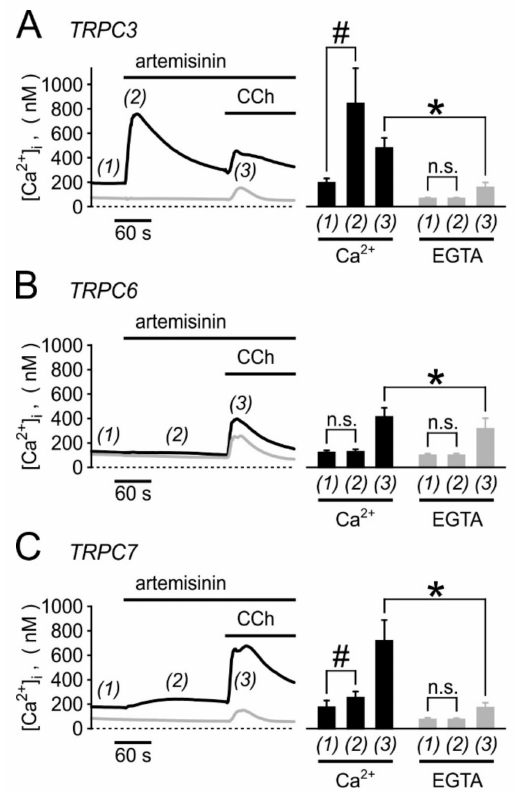
Figure 2. Microfluorometric single-cell analysis of artemisinin-induced increases in [Ca 2 + ] i in fura-2-loaded HEK cells stably expressing TRPC3 ( A ), TRPC6 ( B ), or TRPC7 ( C ). Calibrated [Ca 2 + ] i imaging analysis was performed in cells that overexpressed the indicated TRPC channel during sequential addition of 50 µ M artemisinin and 1 mM carbachol (CCh). Experiments were performed either in standard bath solution, containing 1 mM Ca 2 + (black lines and bars), or in a nominally Ca 2 + -free HBS bu ff er, supplemented with 200 µ M EGTA (grey lines and bars). Time courses of averaged responses (left), and statistical analysis of 6–11 independent imaging experiments with means and S.D. (right) are shown. Significant di ff erences ( p < 0.05, Student´s t -test with paired data: #, with